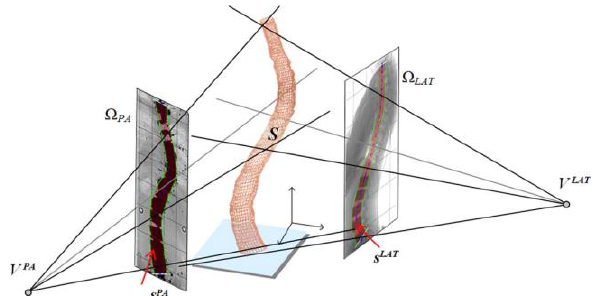
Figure 10. The shape of the object “S” is estimated by the intersection of both visual cones issued from viewpoints V,